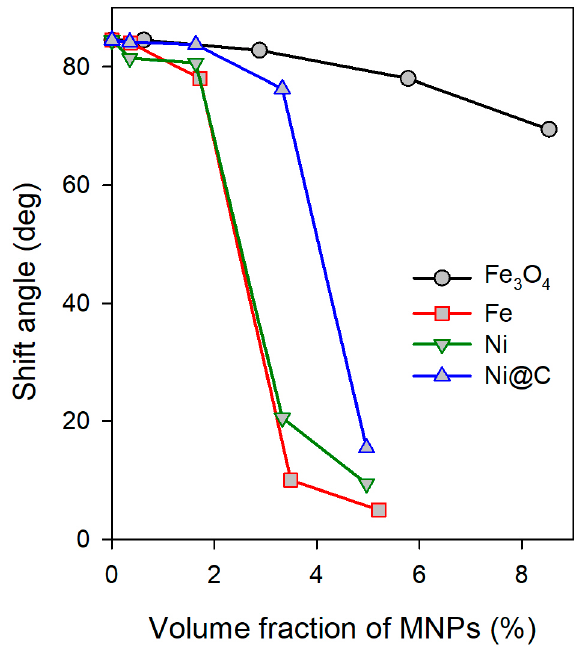
Figure 6. Concentration dependences of shift angle δ for magneto-rheological suspensions with different magnetic particles. δ is averaged over the plateau at 0.1–1 Pa range of shear stress. Frequency 1 Hz. Temperature 25 °C.